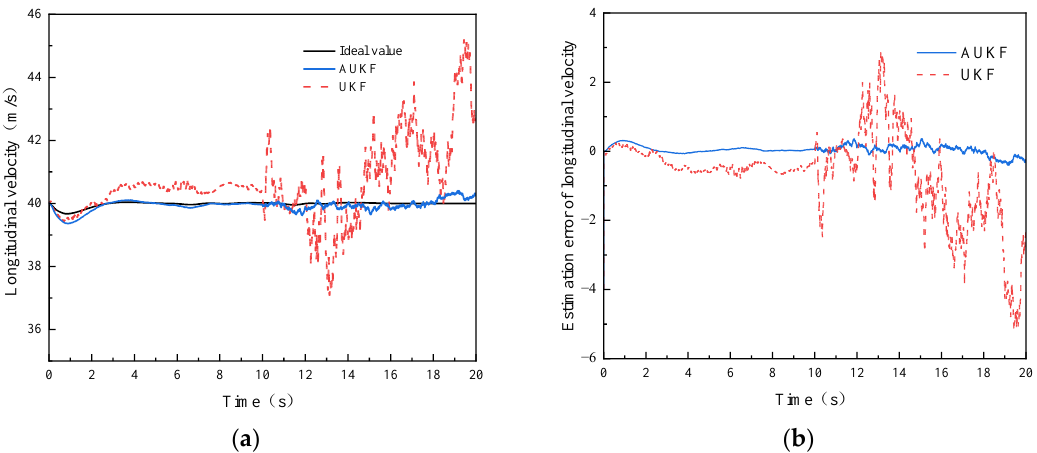
Figure 5. Simulation results of longitudinal velocity. ( a ) Comparison of estimated results and ( b ) comparison of estimated error.